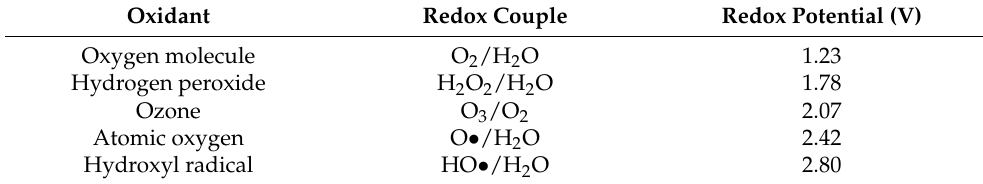
Table 3. Standard potential of oxygen, ozone, and principal oxygenated radicals at 25 °C and 1 atm.